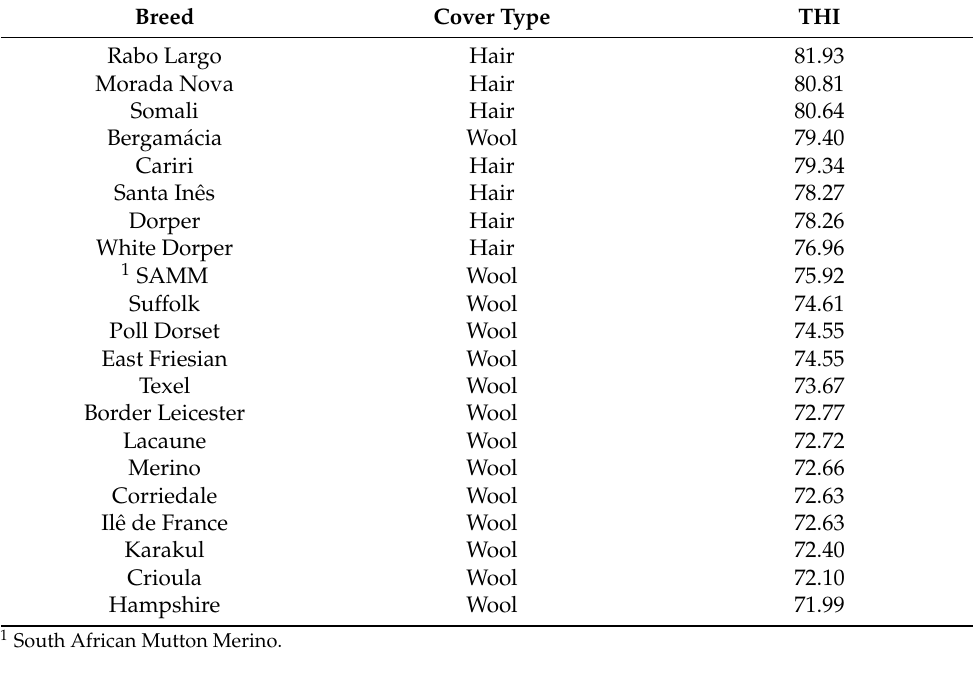
Table 4. Cover type and THI values for the main sheep breeds in Brazil [19] (adapted).